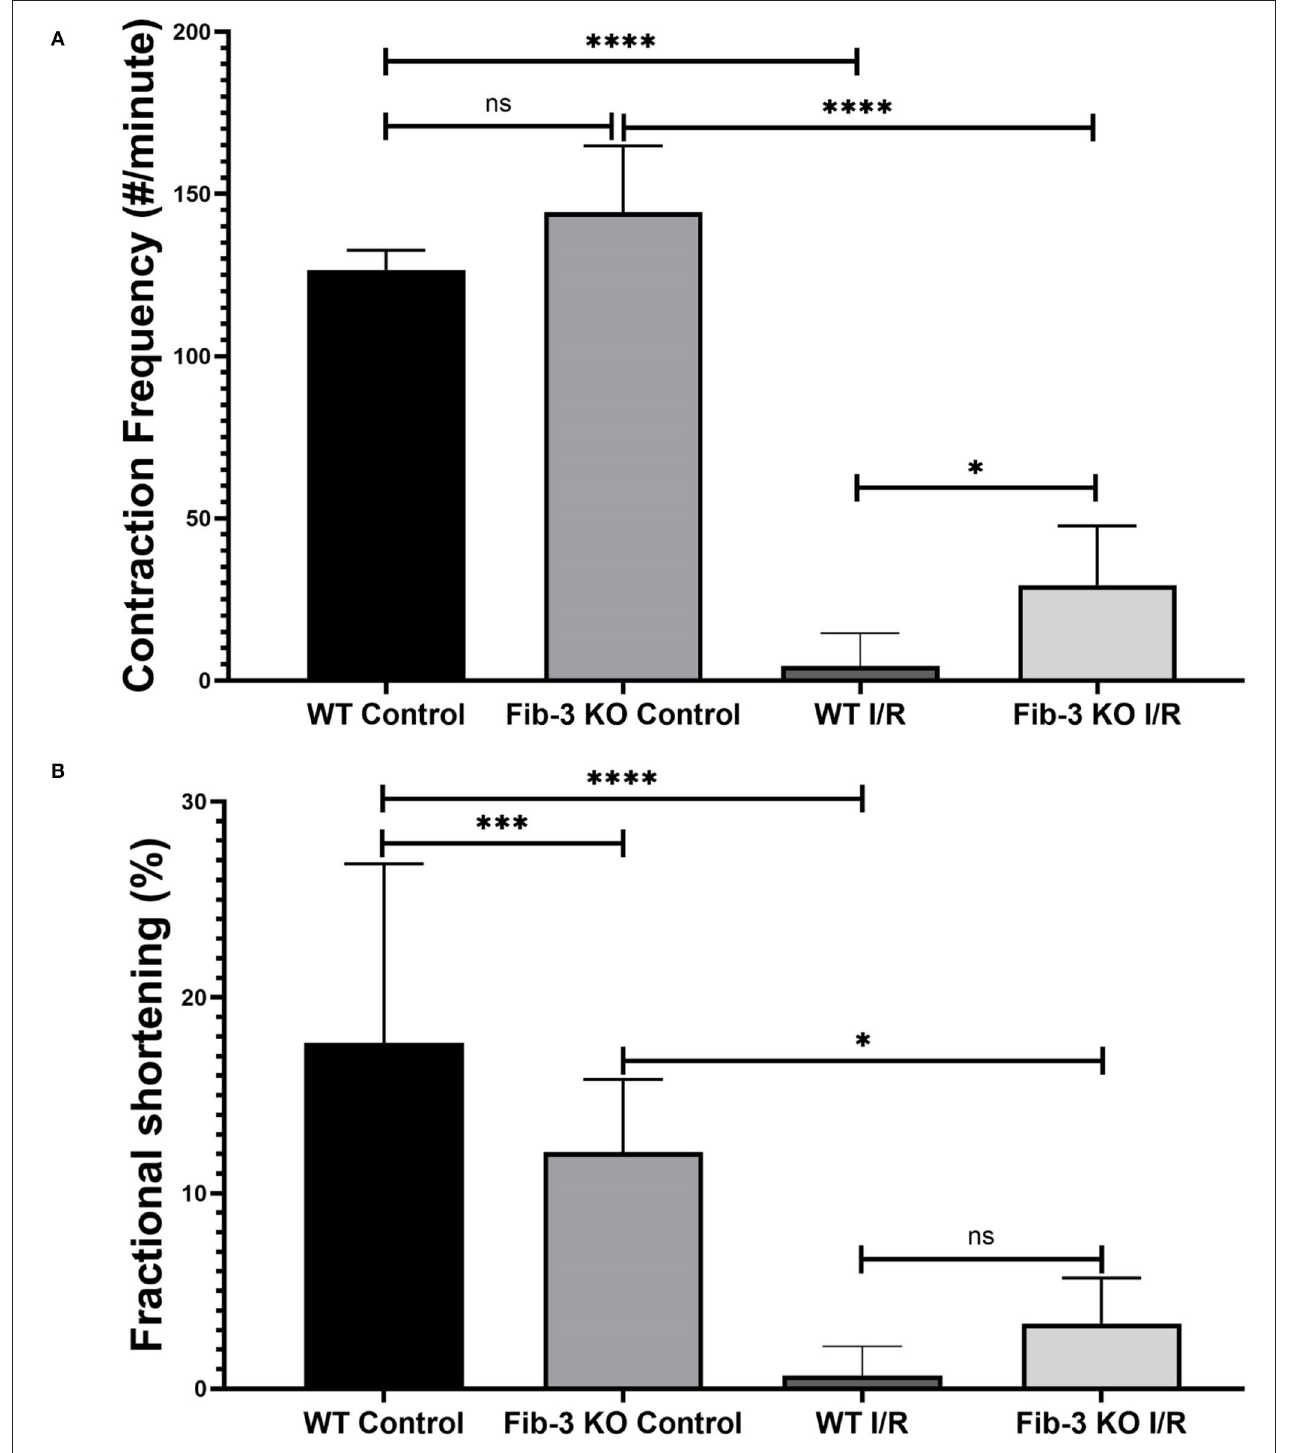
FIGURE 5 | I/R conditions decrease contraction frequency and fractional shortening in CSs. Statistical analysis of contractile frequency (A) and fractional shortening (B) of control and I/R CSs from both WT and Fib-3 KO mouse optimized under Olympus microscope of Ionoptix system. One-way ANOVA with Tukey post-hoc test was used for comparison of all groups, p > 0.05 = ns, p < 0.05 = * , p < 0.001 = *** and p < 0.0001 = **** . Error bars represent the mean ± SD ( n > 5).